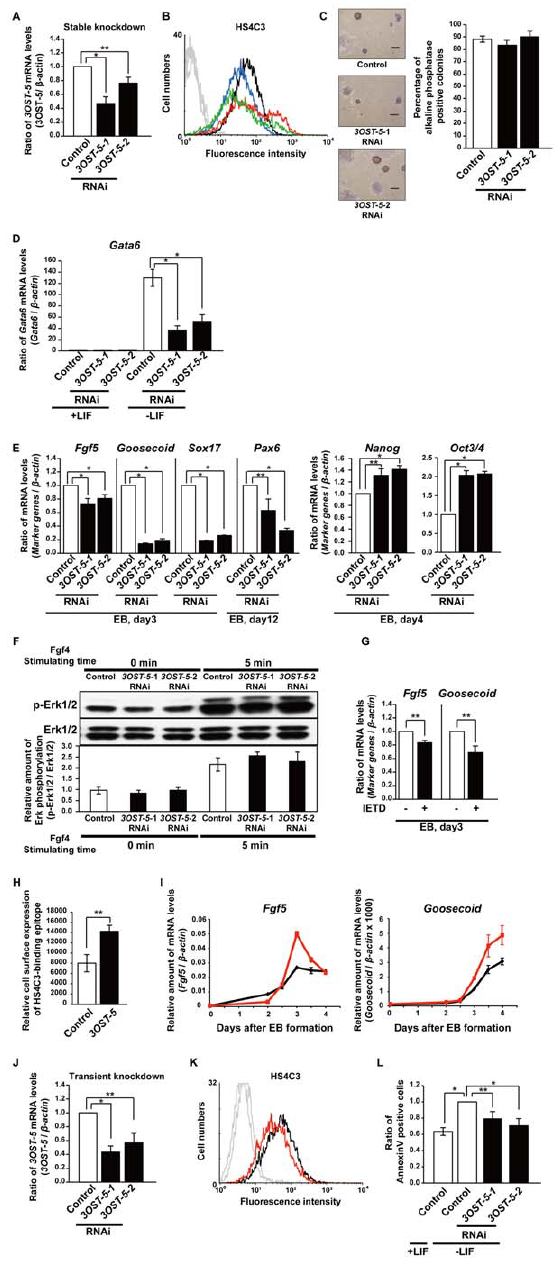
Figure 6. Decrease in the HS4C3-binding epitope inhibits differentiation and apoptosis. (A) and (J) Real time PCR analysis of 3OST-5 in stable (A) and transient (J) 3OST-5 KD cells. The values shown are means 6 SD after normalization against control cells (arbitrary value=1). (B) FACS analysis using the anti-HS antibody HS4C3 ( black line , control ESCs; blue line, stable 3OST-5-1 KD ESCs; red line , control EBs; green line , stable 3OST-5-1 KD EBs). The control cells were transfected with the construct that targeted EGFP . The gray line shows the result obtained for cells not treated with primary antibody. (C) Self- renewal assay with stable 3OST-5 KD cells. Left panels show photographs of representative colonies. Scale bars, 200 m m. The right panel shows the proportion of AP-positive colonies. The values shown are the mean 6 SD. (D) and (E) Real time PCR analysis of marker genes in stable 3OST-5 KD cells at 6 days after LIF withdrawal (D) and at 3 ( Fgf5 , Goosecoid , and Sox17 ), 4 ( Nanog and Oct3/4 ), or 12 ( Pax6 ) days after EB formation (E). The values shown are means 6 SD after normalization against control cells (arbitrary value=1). (F) Western